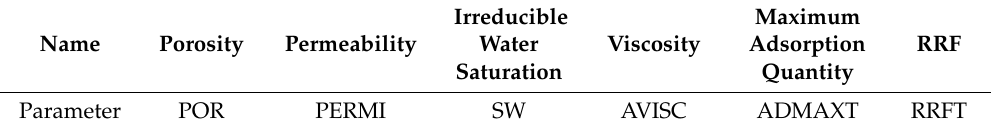
Table 5. The main sensitivity analysis parameters.